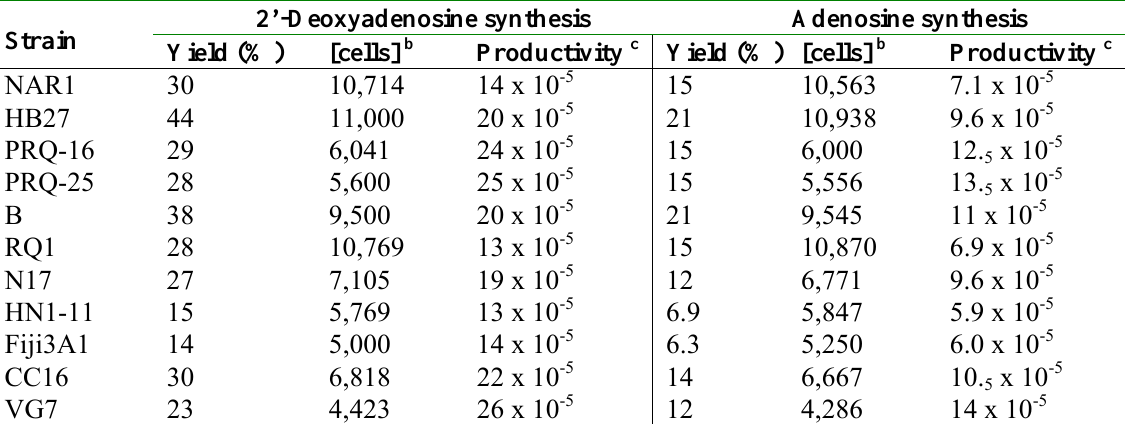
Table 2. Yield and productivity of the reaction dUrd or Urd + adenine using some selected strains a